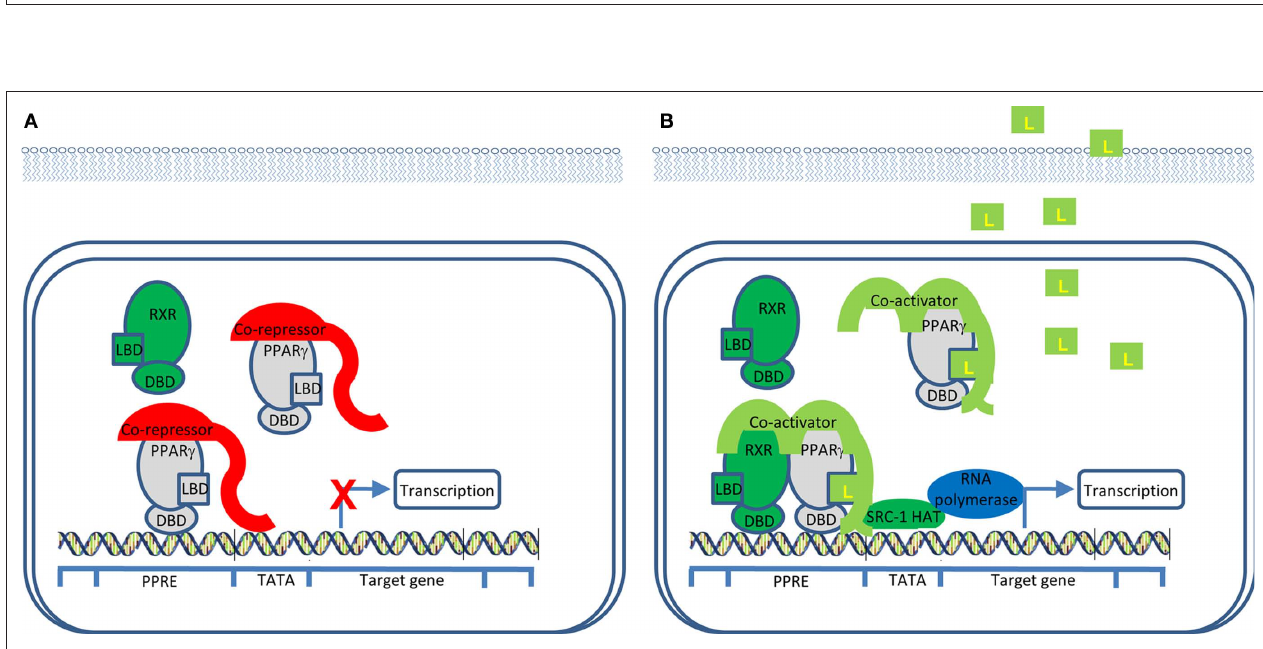
Figure 2 | Scheme of PPAr γ activation and signaling. (A) In the absence of ligand, PPAR γ is bound to co-repressors and may interact with DNA in a manner that prevent transcription. (B) Upon binding the ligand, PPAR γ undergoes conformational changes inducing the recruitment of specific co-activators and allowing hetero-